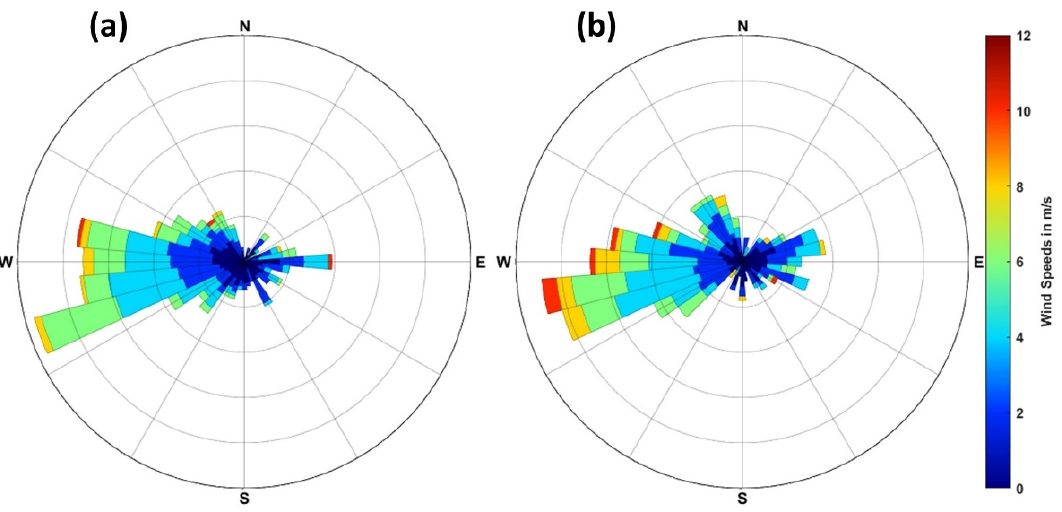
Figure 4. Wind rose diagrams for April ( a ) and May ( b ) 2016. Table 4. Percentage of the wind speed range according to Beaufort scale.